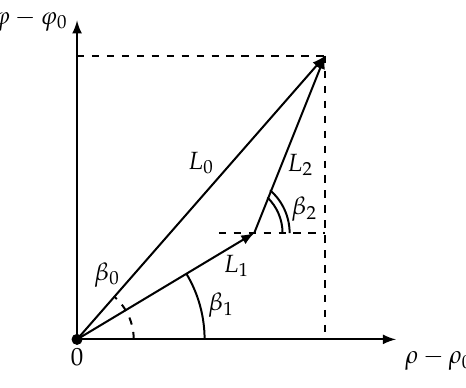
Figure 3. The mobile vehicle in the ( ρ , ϕ ) coordinate